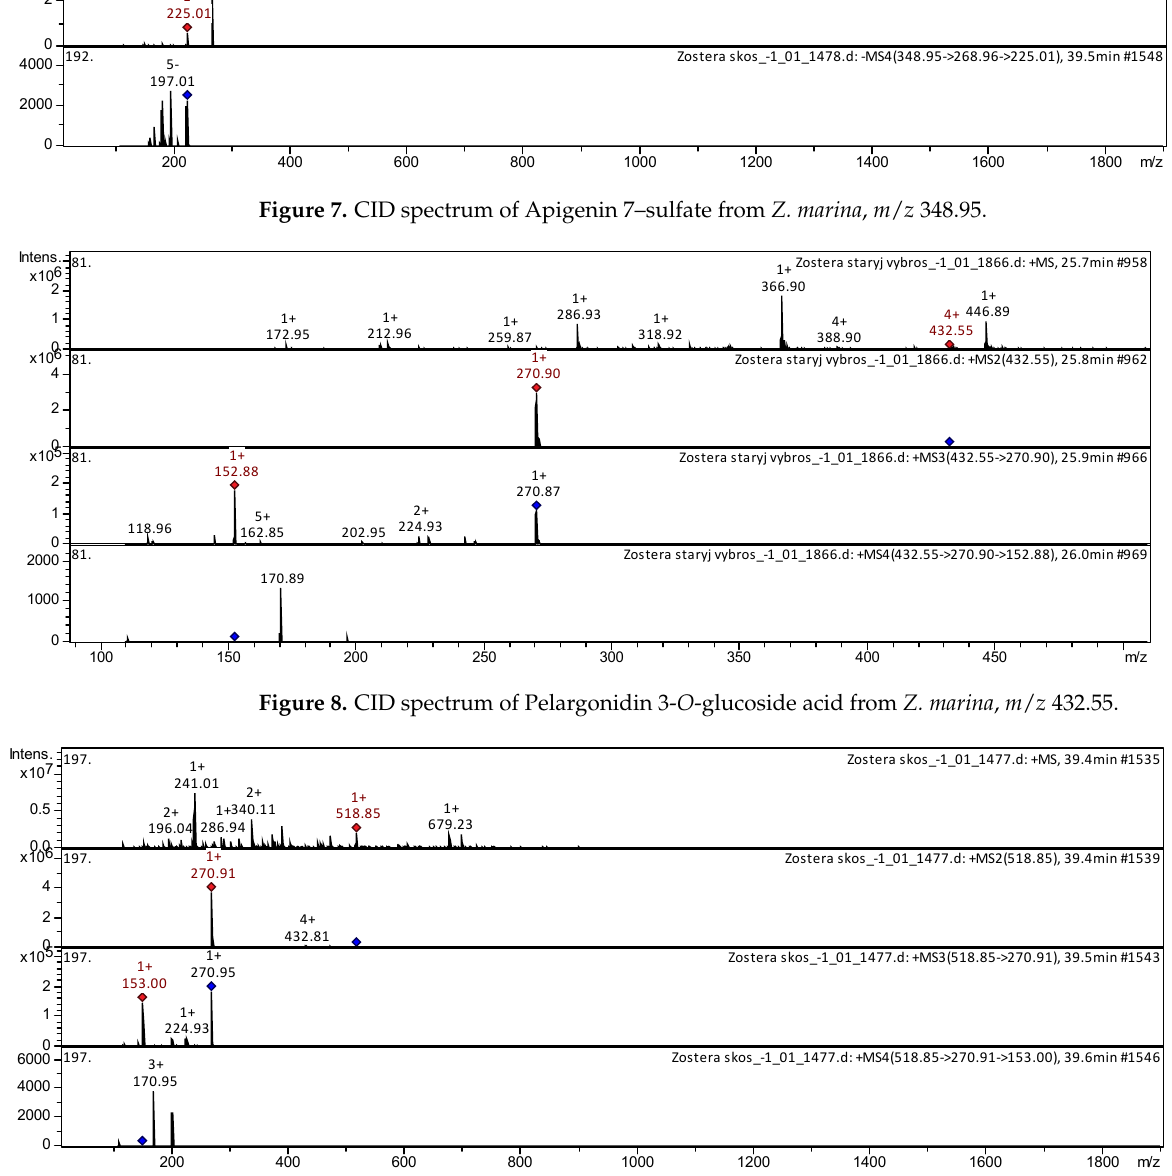
Figure 9. CID spectrum of Pelargonidin-3- O -(6- O -malonyl-beta-D-glucoside) acid from Z. marina , m / z 518.85.